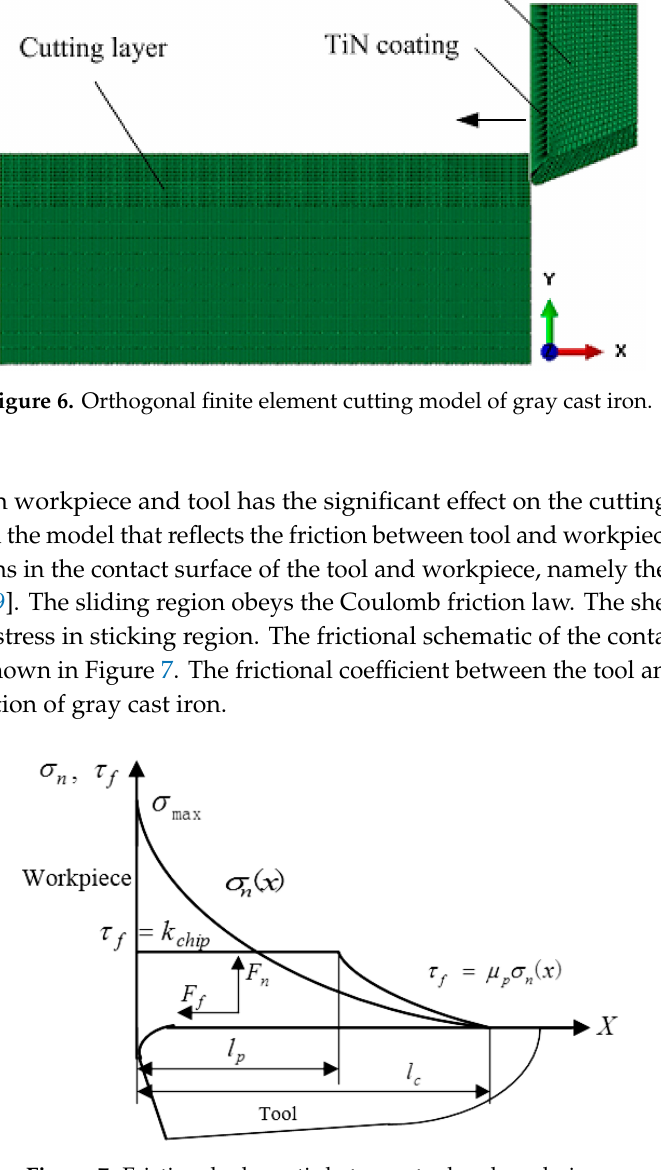
Figure 7. Frictional schematic between tool and workpiece.